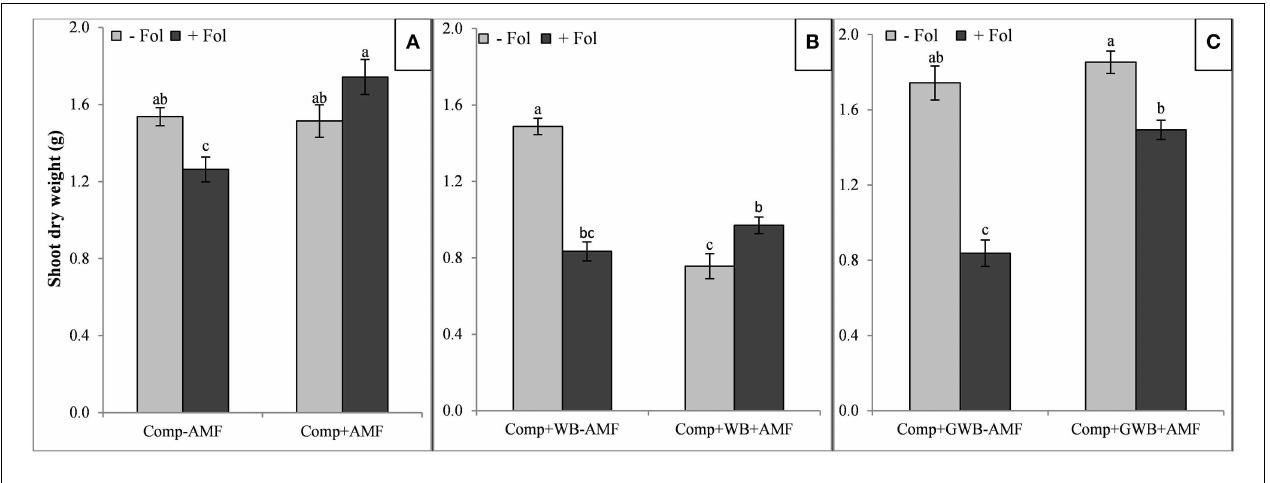
un-inoculated ( − Fol), with AMF ( + AMF) or without AMF ( − AMF) (C) combination of compost and GWB (Comp + GWB) was utilized under the same settings as described for (A,B). Data were recorded 6 weeks after transplanting. Each bar represent mean ± SE, n = 15 , bars with different letters indicate significant differences according to Tukey’s test ( P <